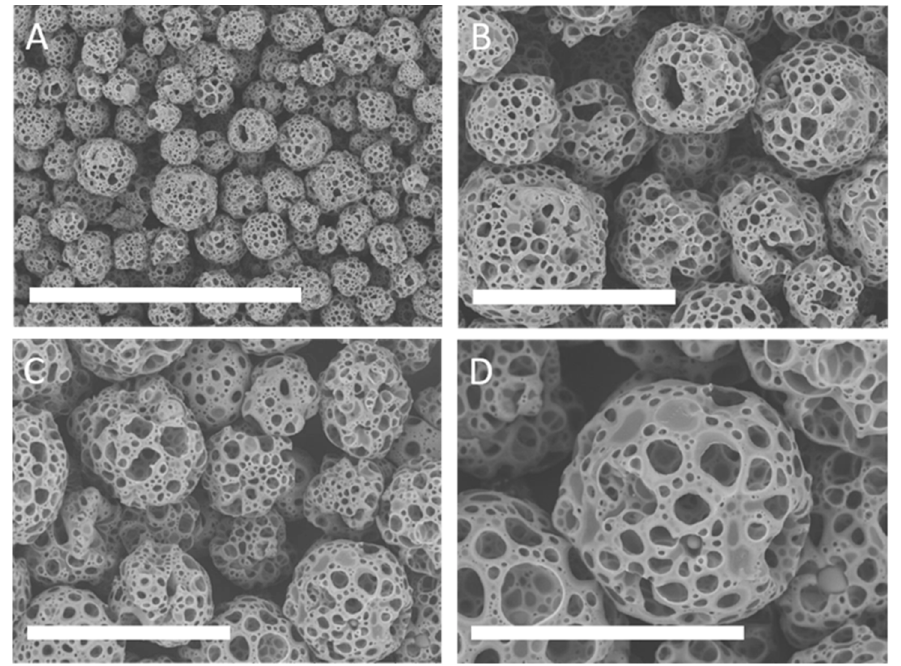
Figure 1. Scanning electron microscopy (SEM) microphotographs to show the morphology of the BR44 microcarrier (MC). SEM examination of this carrier showed a good uniformity of shapes and sizes. BR44 is highly porous. Fold magnification: ( A ): 100×, scale bar 1 mm ( B , C ): 250×, scale bar 300 µm ( D ): 500×, scale bar 200 µm.